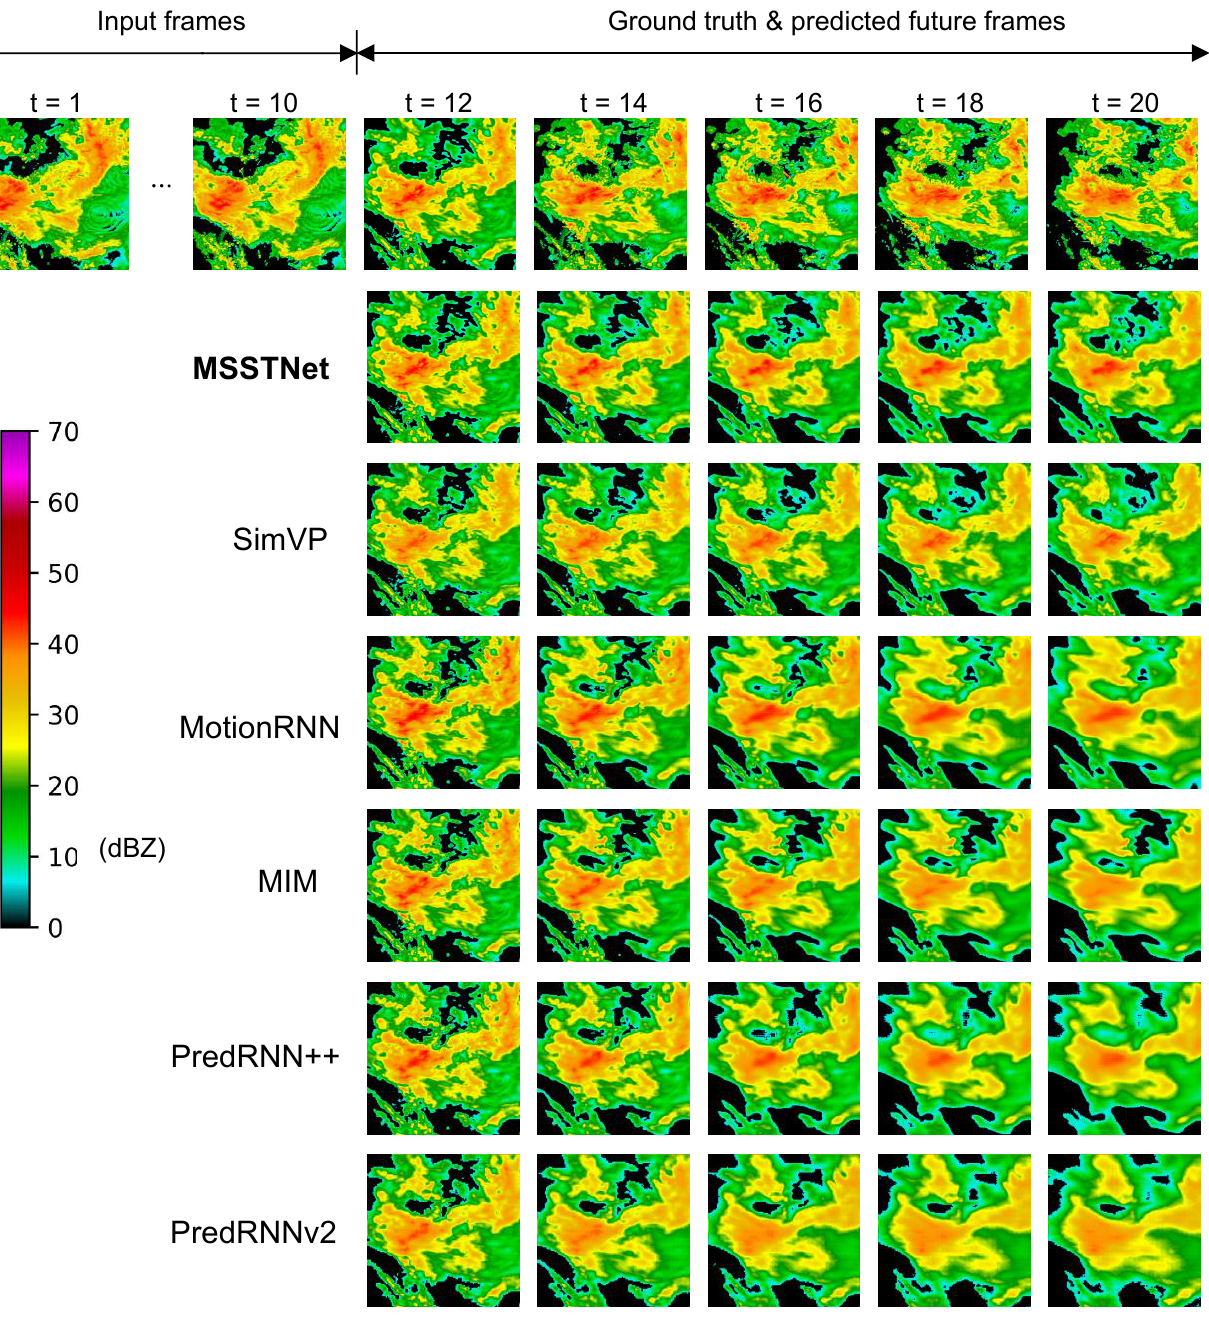
Figure 8. Visualization of radar echo image